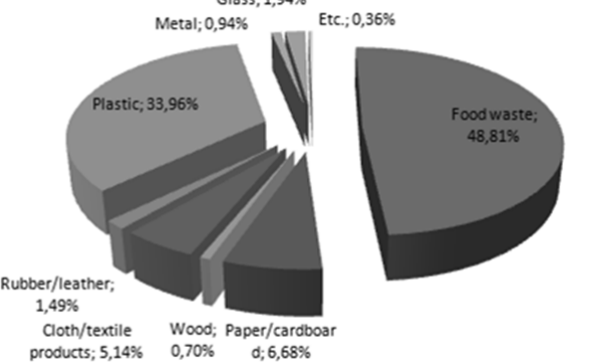
Figure 2. MSW Composition in Lawang Kidul